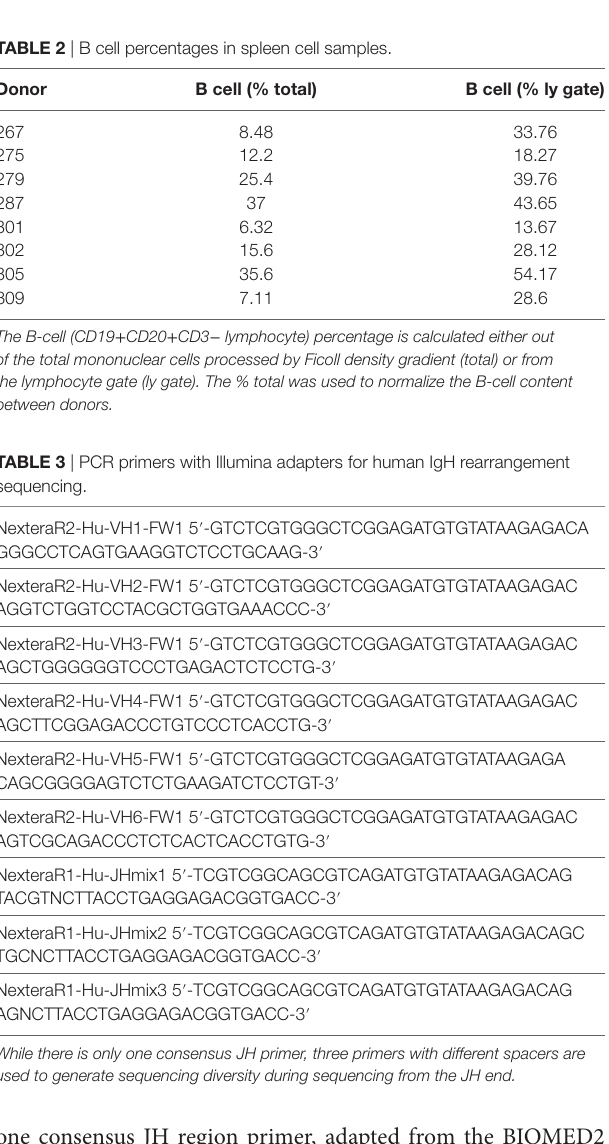
tABlE 2 | B cell percentages in spleen cell samples.